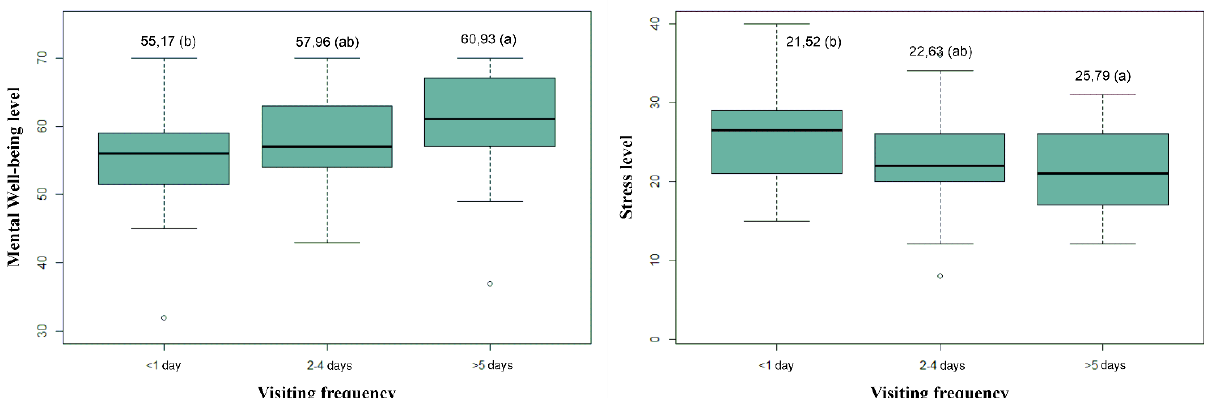
Figure 8 . Box plot with the average factor of visiting frequency related to the level of mental well-being (left) and level of stress (right).